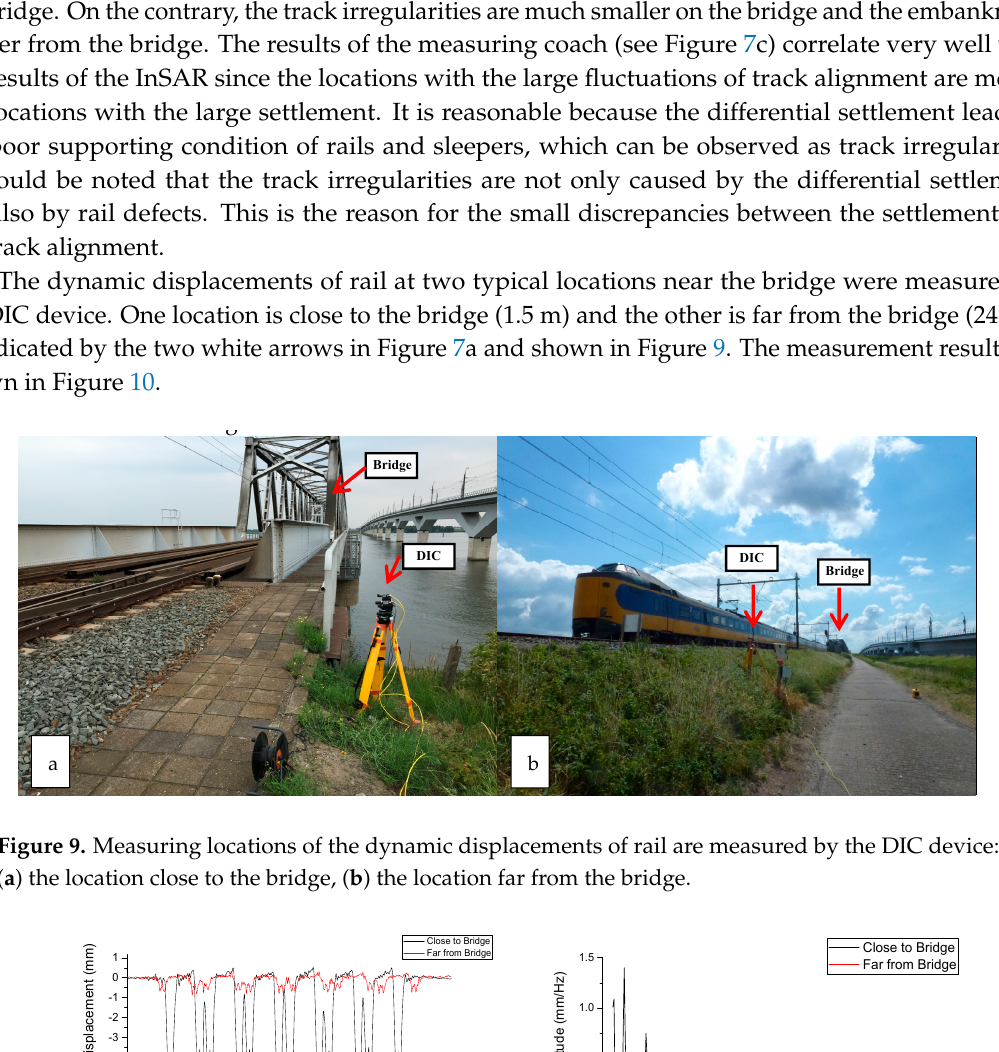
Figure 10. Vertical displacements of rail at 1.5 m and 4.5 m of the transition: ( a ) in the time domain, ( b ) in the frequency domain.